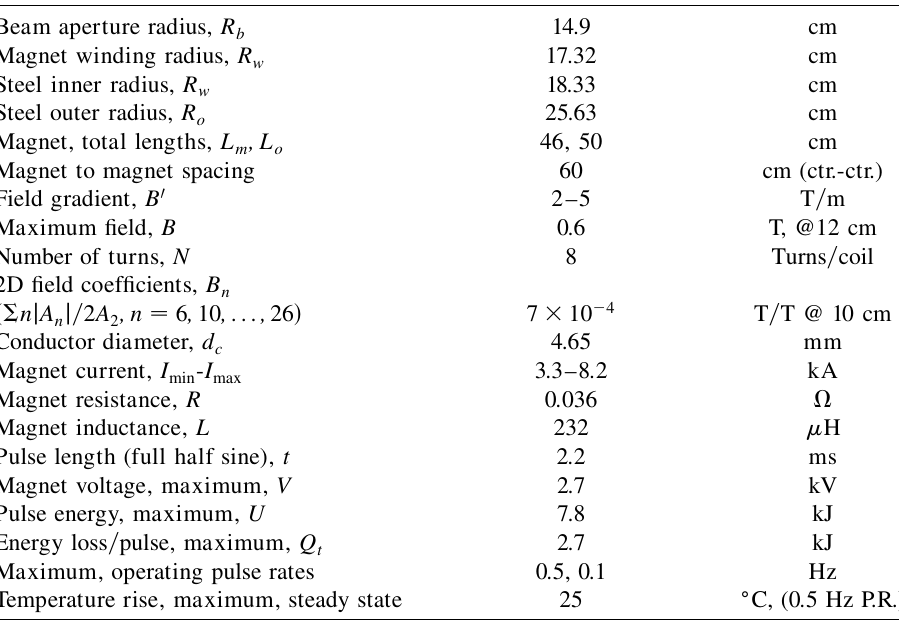
TABLE I. Magnet parameters.